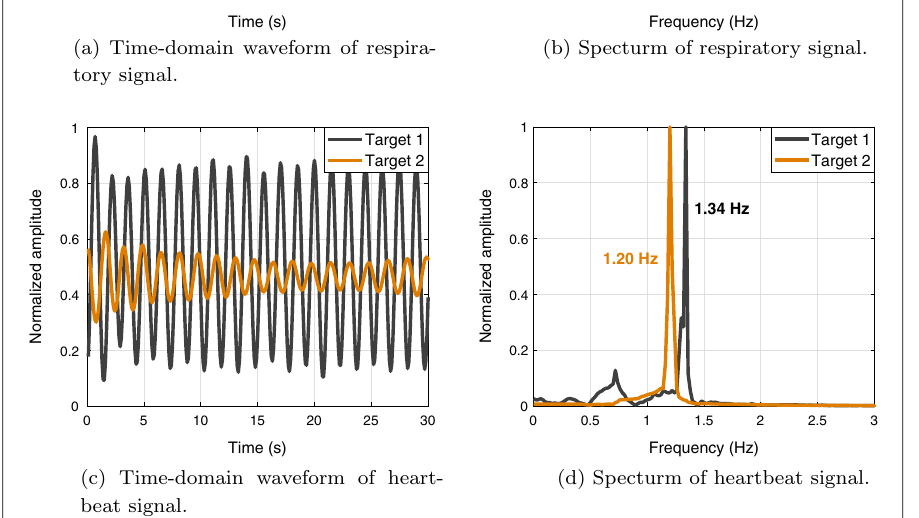
Fig. 11 Time and spectrum of two human